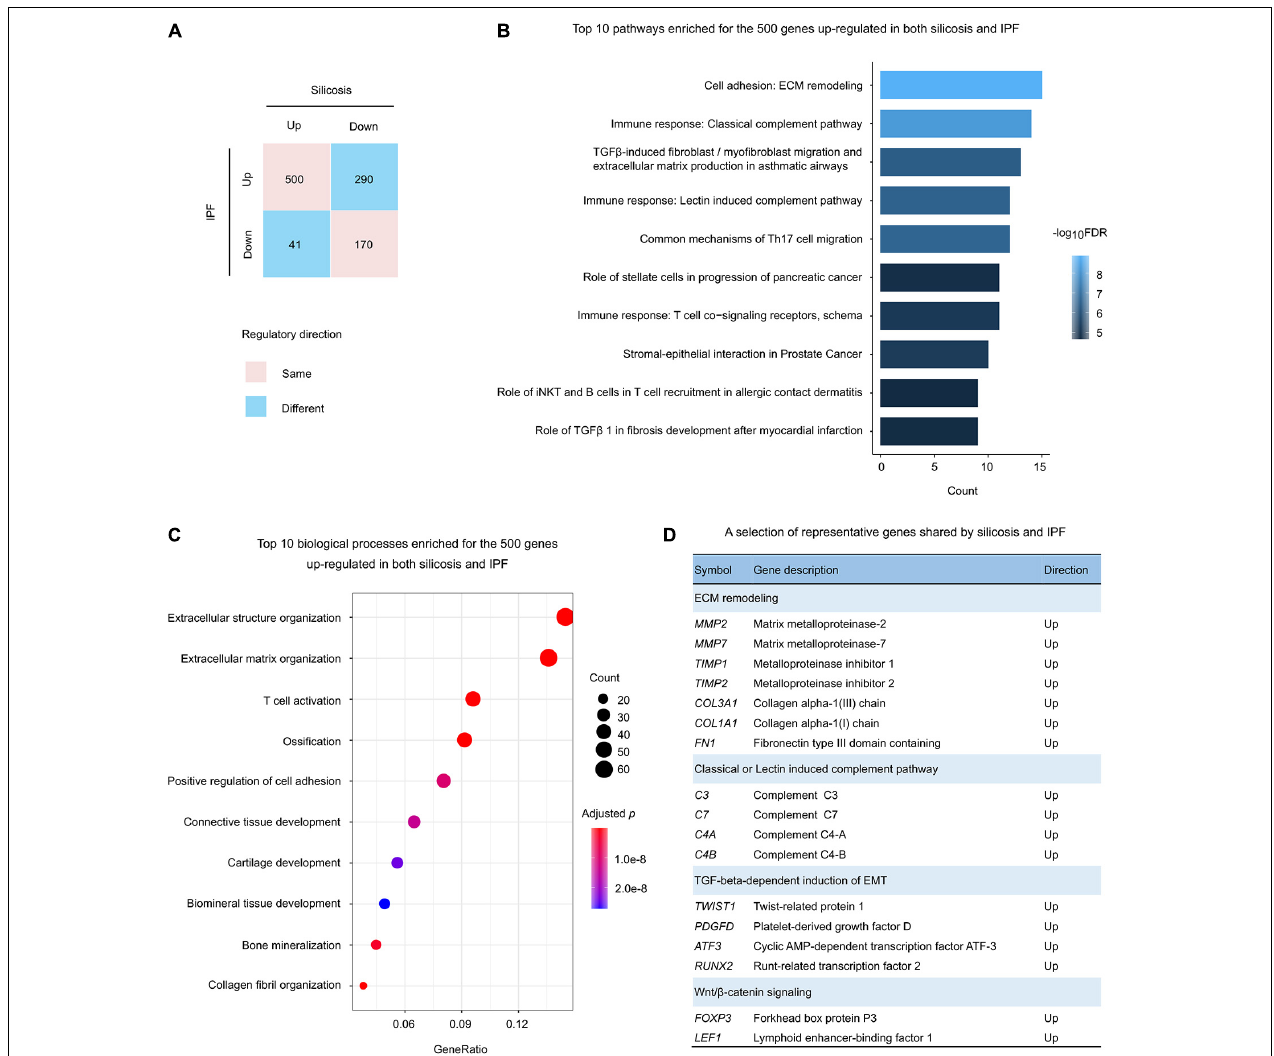
FIGURE 4 | Functional analysis of the genes regulated in both silicosis and IPF. (A) Statistics of the gene counts regulated in both silicosis and IPF. Pink squares indicate genes regulated in the same direction (up or down) in both diseases; blue squares indicate genes regulated in different directions in the two diseases. (B) The top 10 pathways significantly enriched for the 500 genes up-regulated in both silicosis and IPF. (C) The top 10 significant biological processes enriched for the 500 genes up-regulated in both silicosis and IPF. The size of dots reflects the gene counts for each process. Dot color reflects adjusted p -values, where the most significant result is red. (D) Representative genes selected from significant pathways shared by silicosis and